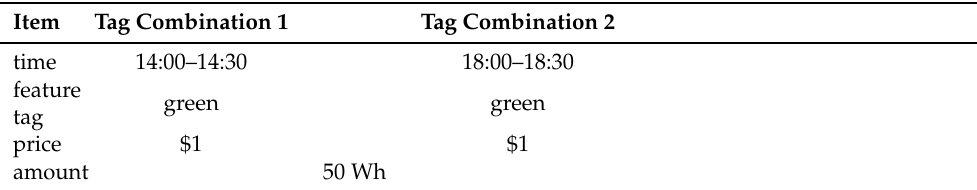
Table 5. Example of bid expressing needs for time based bidding.